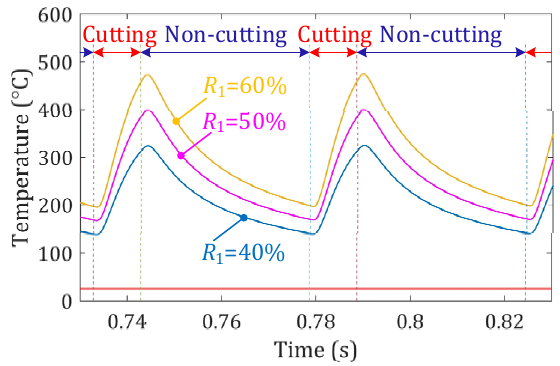
Figure 8. Temperature histories calculated by the proposed method at ( x , y , z ) = (0.1, 0.6, 1.3).